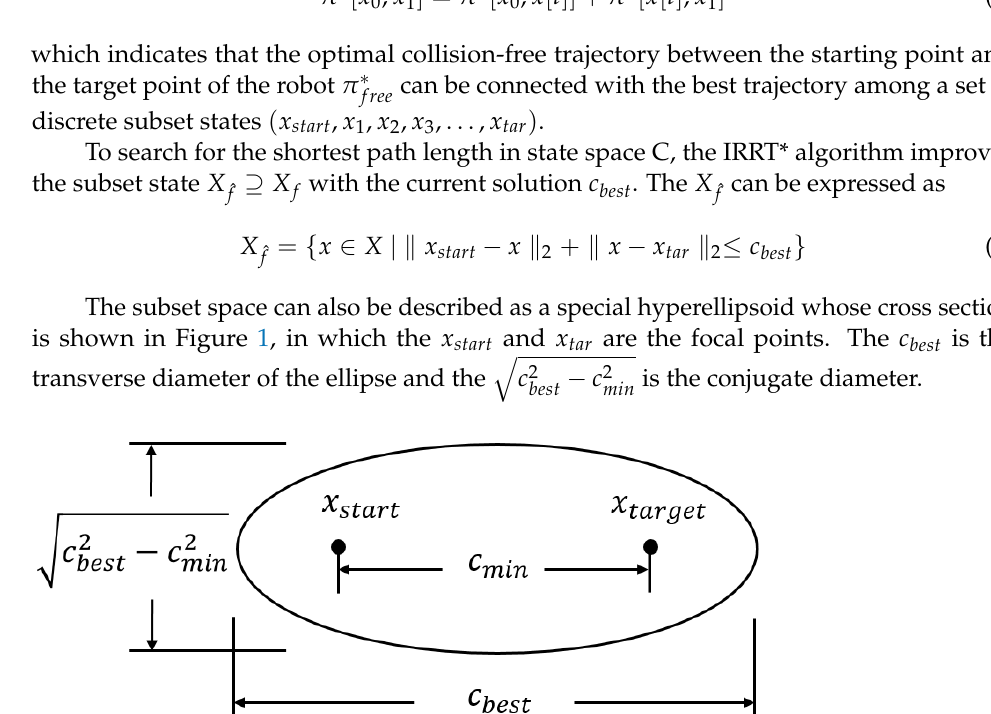
Figure 1. The heuristic sampling ellipse domain. The 𝑥 𝑠𝑡𝑎𝑟𝑡 and 𝑥 𝑡𝑎𝑟 are the focal points. 𝑐 𝑚𝑖𝑛 and 𝑐 𝑏𝑒𝑠𝑡 are the theoretical minimum cost and the current solution cost between the start point and target point, respectively.